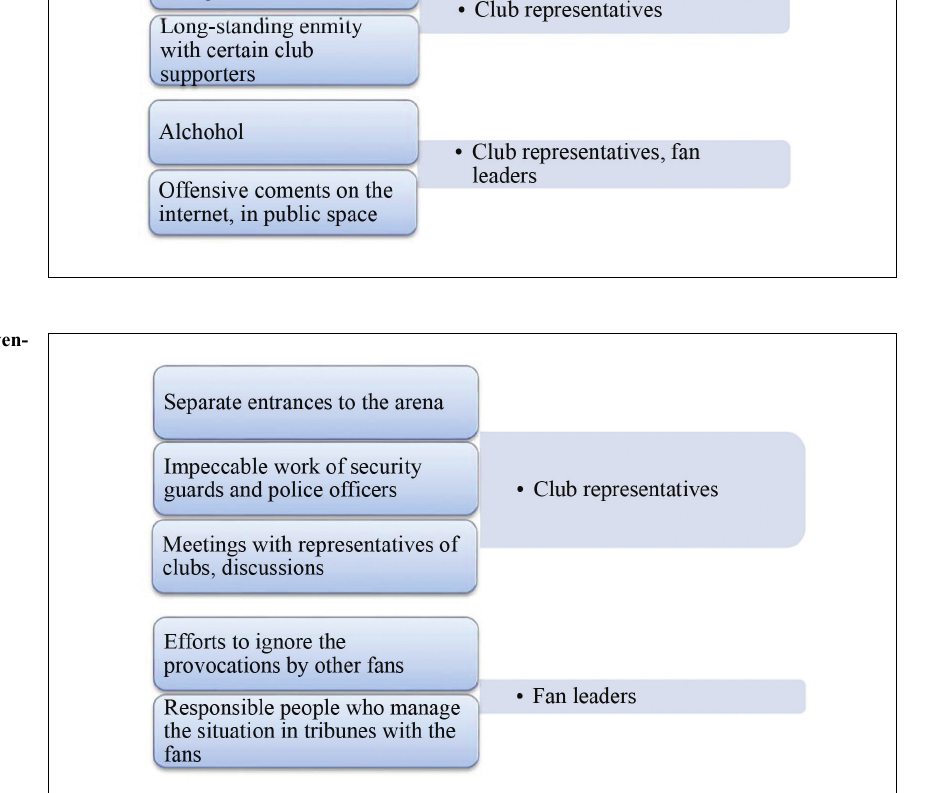
Figure 6. The main causes of